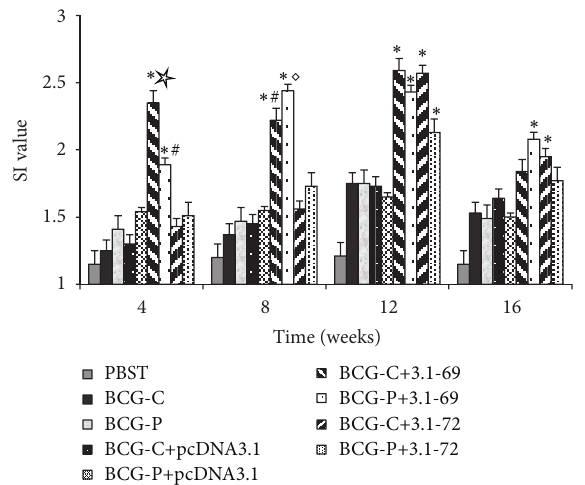
Figure2:Analysisofthelymphoproliferativeresponsetotheprime- boost approach. Splenocytes were prepared from individual mice aftertheanimalswerekilled,andproliferationwasanalyzedbyMTT method using the TB-PPD stimulating as described in Section 2. The proliferation was measured by SI, and the data are presented as means ± standard errors. ∗ 𝑃 < 0.01 versus PBST, BCG-C, BCG-P, BCG-C+pcDNA3.1, or BCG-P+pcDNA3.1 groups. # 𝑃 < 0.05 versus BCG-C+3.1-72 group. ◊ 𝑃 < 0.05 versus BCG-C+3.1-72 or BCG- P+3.1-72 group. f 𝑃 < 0.05 versus BCG-P+3.1-69, BCG-C+3.1-72, or BCG-P+3.1-72